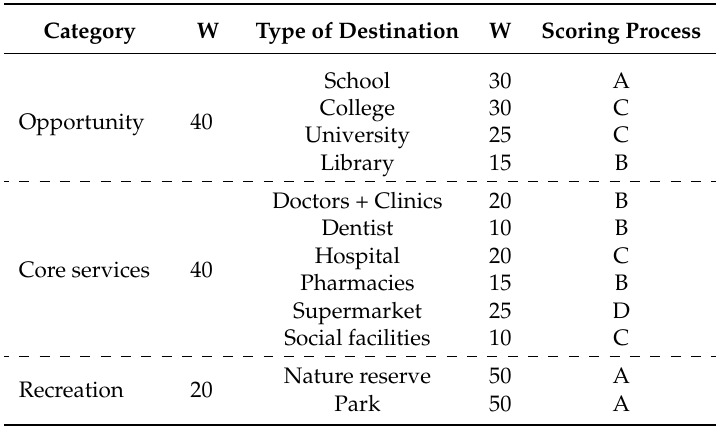
Table 3. Weights for destinations and categories.